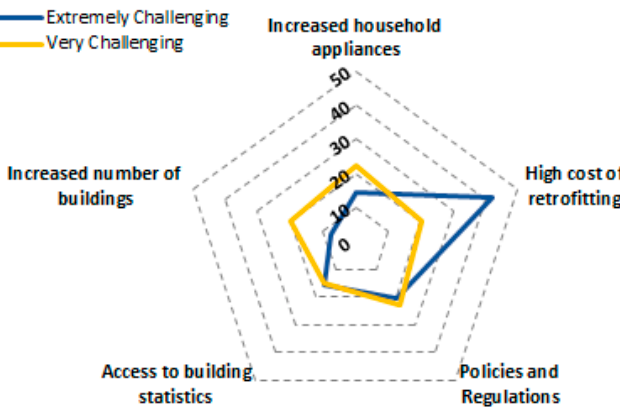
Figure 11. Common challenges (%) a ff ecting building retrofit measures in Shanghai.